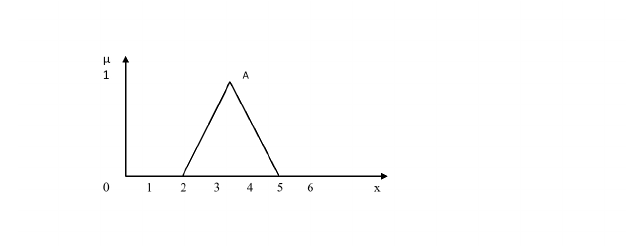
Figure 1. Fuzzy group A membership function.